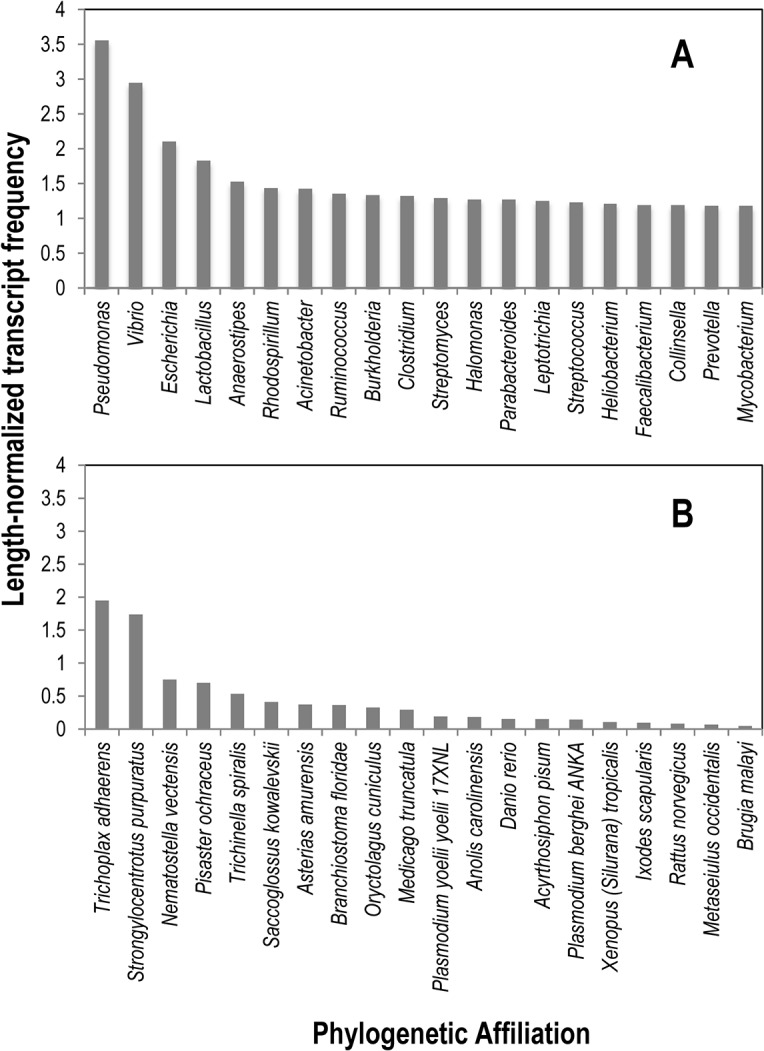
Twenty most abundant bacterial (A) and eukaryotic (B) phylogenetic affiliations amongst all four metatranscriptomic libraries prepared from Pycnopodia helianthoides tissues.Phylogenetic affilitation was determined by BLASTx analysis against the non-redundant (nr) database at NCBI. Affiliations were normalized by dividing the percentage of reads amongst all reads by the length of contigs assigned to that affilitation.